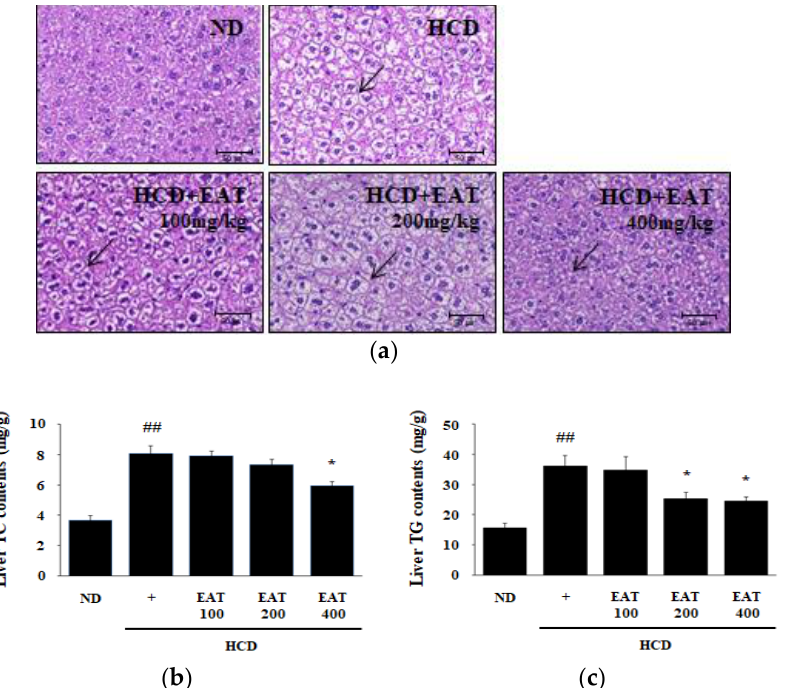
Figure 4. Effect of EAT on hepatic histological analysis and function in an HCD-induced C57BL/6 mouse model. ( a – c ) To assess the change induced by HCD, liver was collected and ( a ) histologically analyzed to detect lipid accumulation. Liver was fixed in 10% neutral buffered formalin and embedded in paraffin. The paraffin blocks were cut into 5 μm sections and stained with H&E. The accumulation of fat globules in liver was observed under a light microscope at 200× magnification ( b , c ). To assess liver function, liver lipid was extracted. The hepatic function determined as ( b ) TC and ( c ) TG contents was measured. Values are expressed as mean ± SD; ## p < 0.01 compared with the ND group; * p < 0.05 compared with the HCD group.